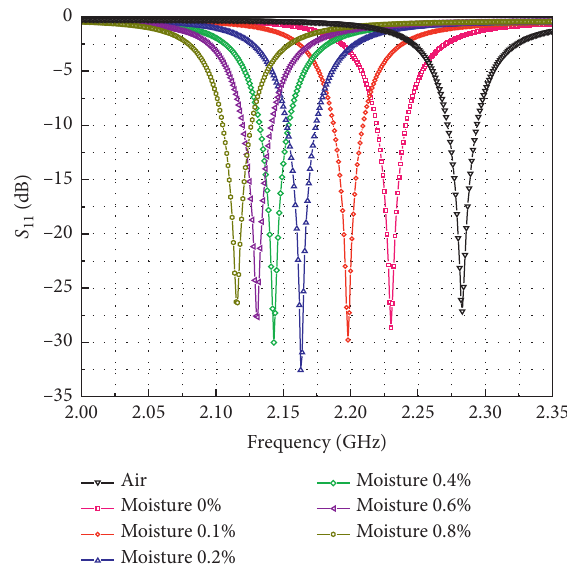
Figure 7: Simulation results for the different relative permittivity values of the microfluidic